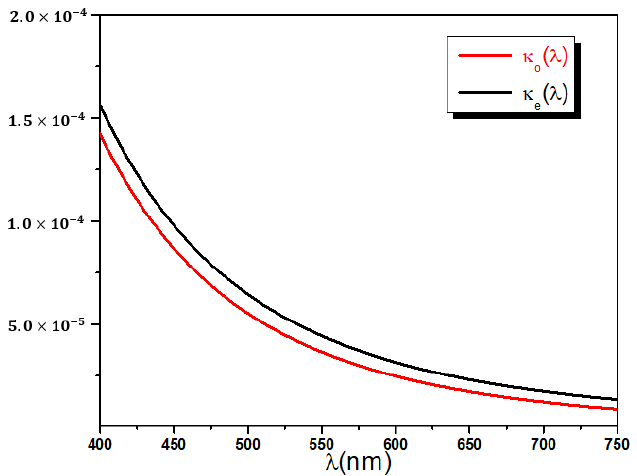
Figure 12. Ordinary and extraordinary extinction coefficients dispersion curves calculated using Cauchy model and the best fit parameters.